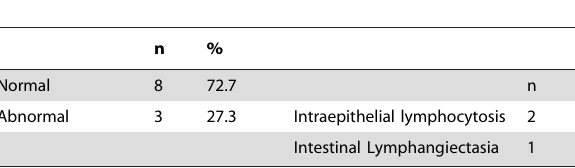
Table 4. Terminal ileal histopathological